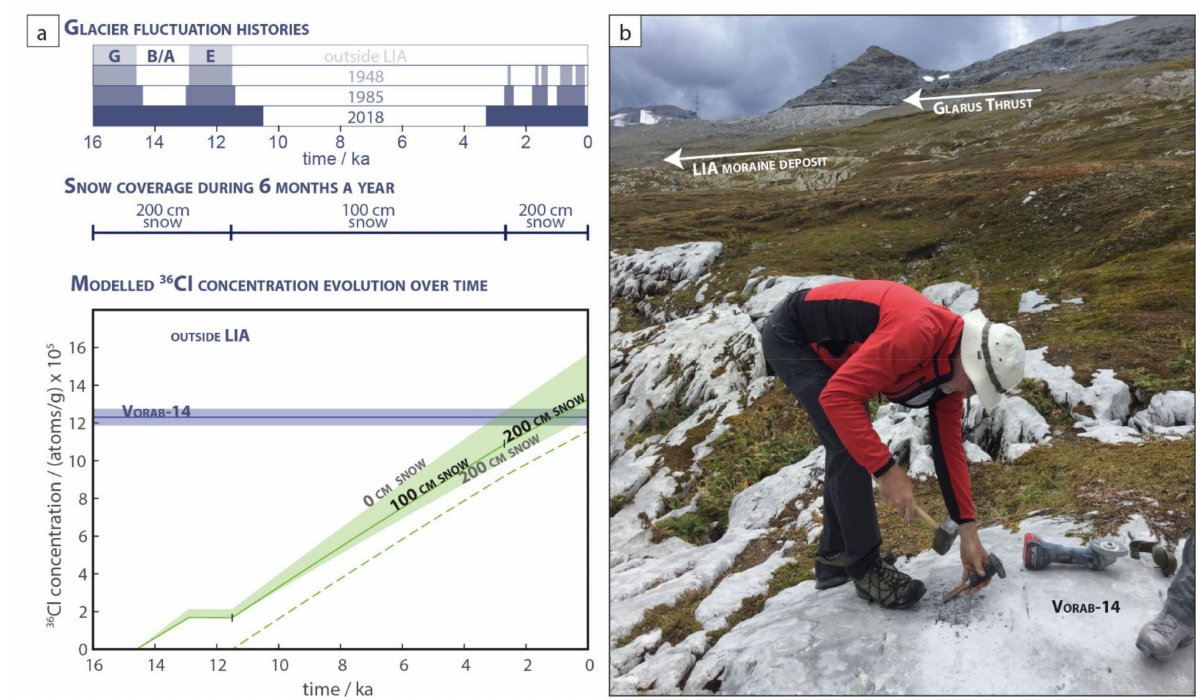
Figure 6. Inputs and output of the MECED model. ( a ) In the top bar diagram, the blue bars show periods of glacier coverage for each sample group (see Figure 2 and text for details). All sites were covered continuously during the last glacial maximum and Gschnitz stadial glaciers (G) of the Oldest Dryas. All groups except the 2018 group were exposed during the Bølling/Allerød interstadial (B/A) then covered again by the Egesen stadial glacier (E) during the Younger Dryas cold phase. This was followed by a longer ice-free phase before the late Holocene glacier advances. Just below, snow depth input shows that until the end of the Egesen and during the late Holocene 200 cm of snow for 6 months a year was used in the model and only 100 cm of snow during the Holocene warm period in between. The graph below shows the modelled 36 Cl concentration increase (solid green line) evolution with time (along the x -axis) for the sample location of Vorab-14 using the glacier fluctuation history for the group outside LIA, showing the increase in 36 Cl (green line) during first exposure during the B/A (14.6–12.9 ka), no production while covered by the Egesen stadial glacier (12.9–11.5 ka) and again an increase in 36 Cl in the exposed bedrock surface during the entire Holocene. The green band shows the effect of snow depth during ice-free times, where the upper boundary was modelled without any snow and the lower limit by using 200 cm for the entire period. The solid green line used reasonable snow values mentioned in the text. The blue horizontal line shows the AMS-measured 36 Cl nuclide concentration along with the uncertainty. The dashed green line shows the modelled concentration if the sample site only became ice-free after the Egesen glacier, highlighting that with this scenario the modelled concentration is lower than the one actually measured, demonstrating why an ice-free period with 36 Cl production of the B/A has to be included. ( b ) Sample location of Vorab-14 with the LIA moraine ridge and the Glarus thrust in the back. See Figures 2 and 3 for the location of samples and